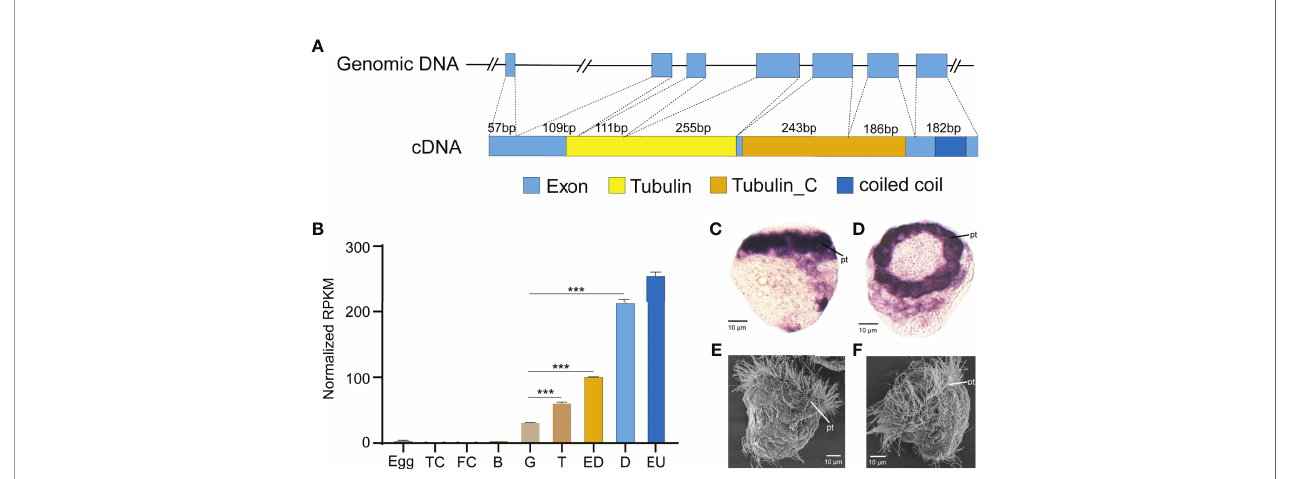
FIGURE 2 | Expression and gene structure of Cg b -tubulin . (A) Structures of the genomic DNA and cDNA of Cg b -tubulin. Seven exons and six introns in total. cDNA was predicted to encode two tubulin domains, one coiled-coil domain. (B) Expression pro fi le of b -tubulin gene in C . gigas angulate at different developmental stages, TC, two cells; FC, four cells; B, blastula; G, gastrula; T, trochophore; D, D-shape larvae; EU, early umbo larva. Error bars represent means ± SD of three independent repeats. One-way ANOVA were used for signi fi cance analysis (three asterisks represent p < 0.001). (C, D) In situ hybridizations shows C . gigas angulate larvae at 8 hpf, which high-level expression of Cg b -tubulin is detected in ciliated cells. (E, F) SEM shows a comparable developmental stage of C.gigas angulate larvae. pt,